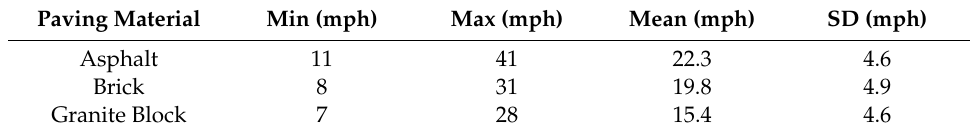
Table 2. Descriptive statistics for vehicle speeds on di ff erent paving surfaces. SD = standard